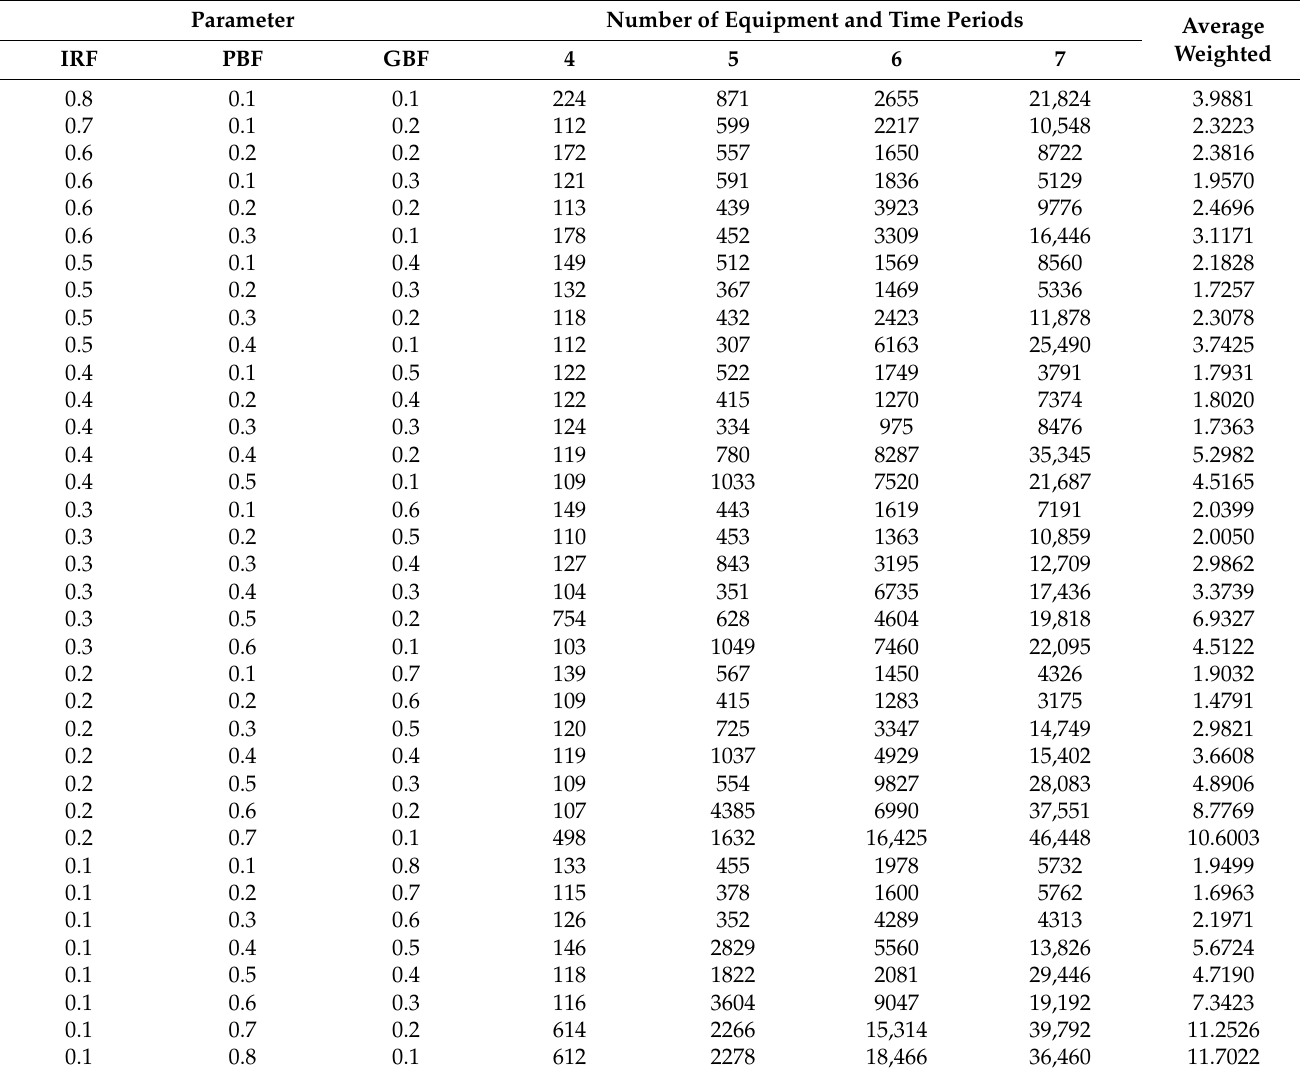
Table 3. Comparison table of iterations of